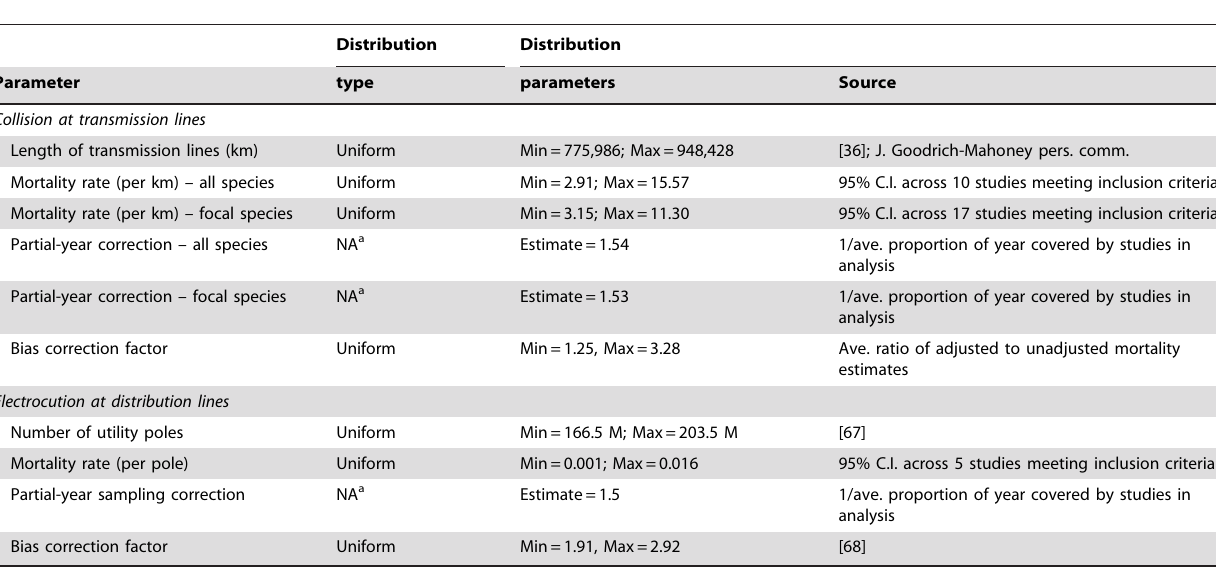
Table 2. Probability distributions used for estimation of bird mortality at power lines in the United States.